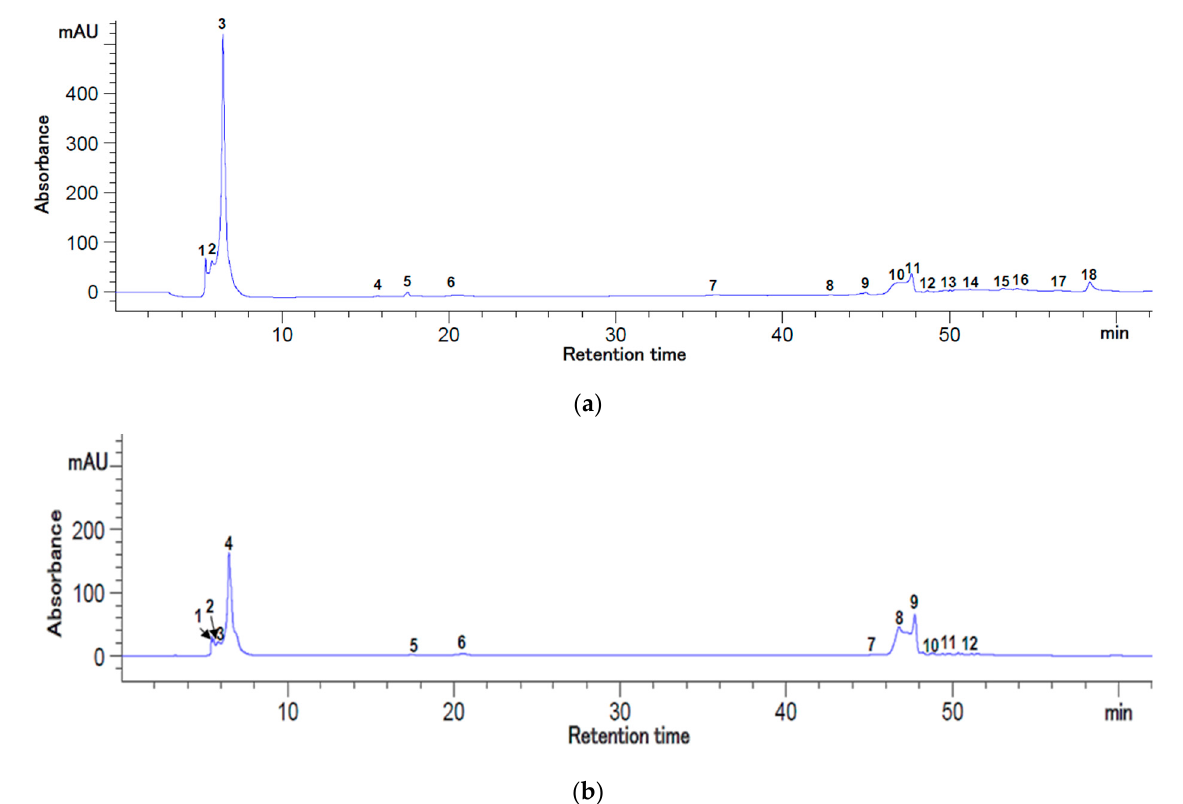
Figure 1. HPLC chromatograms for the flavonoids and polyphenols from rosehip’s extract (1 M) at 280 nm ( a ) and 320 nm ( b ). Peaks’ identification: ( a ) 1—gallic acid; 2—chlorogenic acid; 3—epicate-